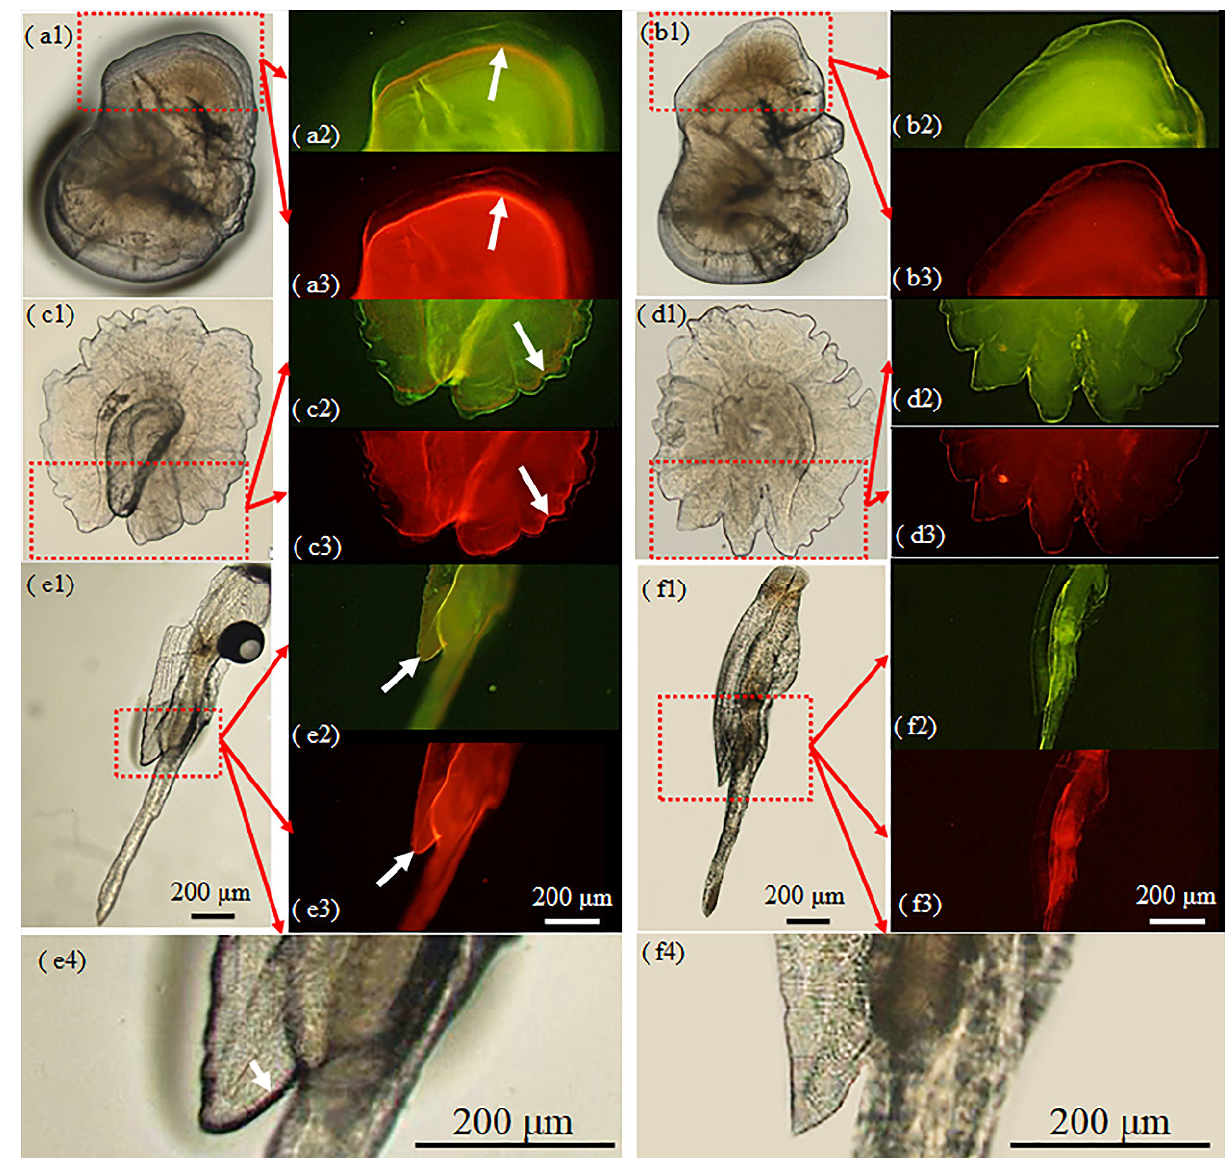
Figure 2. The typical patterns of marking when alizarin complexone (ALC) is used on otoliths (lapillus, sagitta, and asteriscus) from juvenile silver carp, Hypophthalmichthys molitrix . Note: ( a1 ), ALC-marked lapilli under transmitted light; ( a2 ), ALC-marked lapilli under blue excitation light; ( a3 ), ALC-marked lapilli under green excitation light; ( b1 ), control lapilli under transmitted light; ( b2 ), control lapilli under blue excitation light; ( b3 ), control lapilli under green excitation light; ( c1 ), ALC-marked asterisci under transmitted light; ( c2 ), ALC-marked asterisci under blue excitation light; ( c3 ), ALC-marked asterisci under green excitation light; ( d1 ), control asterisci under transmitted light; ( d2 ), control asterisci under blue excitation light; ( d3 ), control asterisci under green excitation light; ( e1 ), ( e4 ) (enlarged view), ALC-marked sagittae under transmitted light; ( e2 ), ALC-marked sagittae under blue excitation light; ( e3 ), ALC-marked sagittae under green excitation light; ( f1 ), ( f4 ) (enlarged view), control sagittae under transmitted light; ( f2 ), control sagittae under blue excitation light; ( f3 ), control sagittae under green excitation light. The white arrows point to the fluorescent marks.